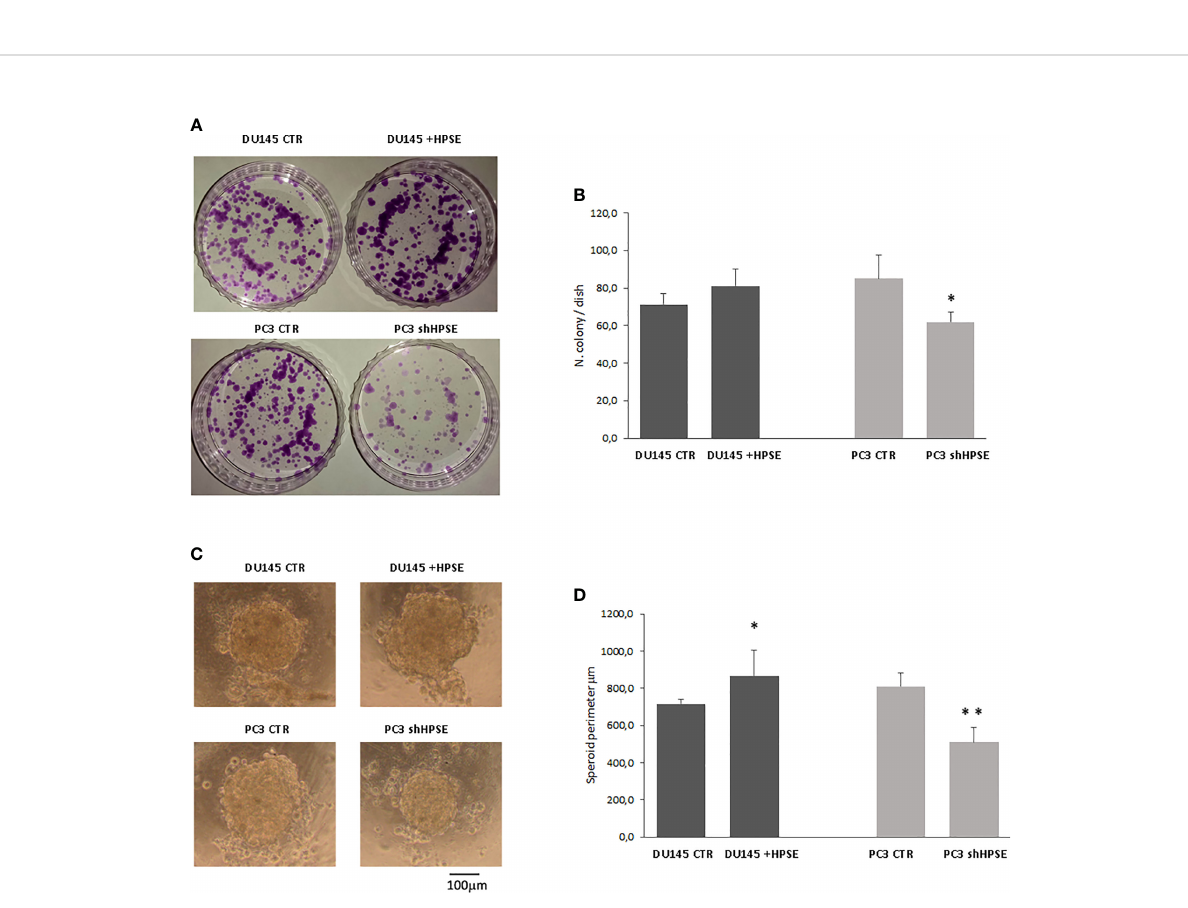
FIGURE 4 Stemness properties in prostate cancer cells. Representative images of colony (A) and sphere (C) assays evaluated in DU145 and PC3 cells. (B, D) Bars represent the quanti fi cation of colony and sphere assay respectively and are expressed as mean ± SD values; n=8. **p < 0.001, *p<0.05 vs.